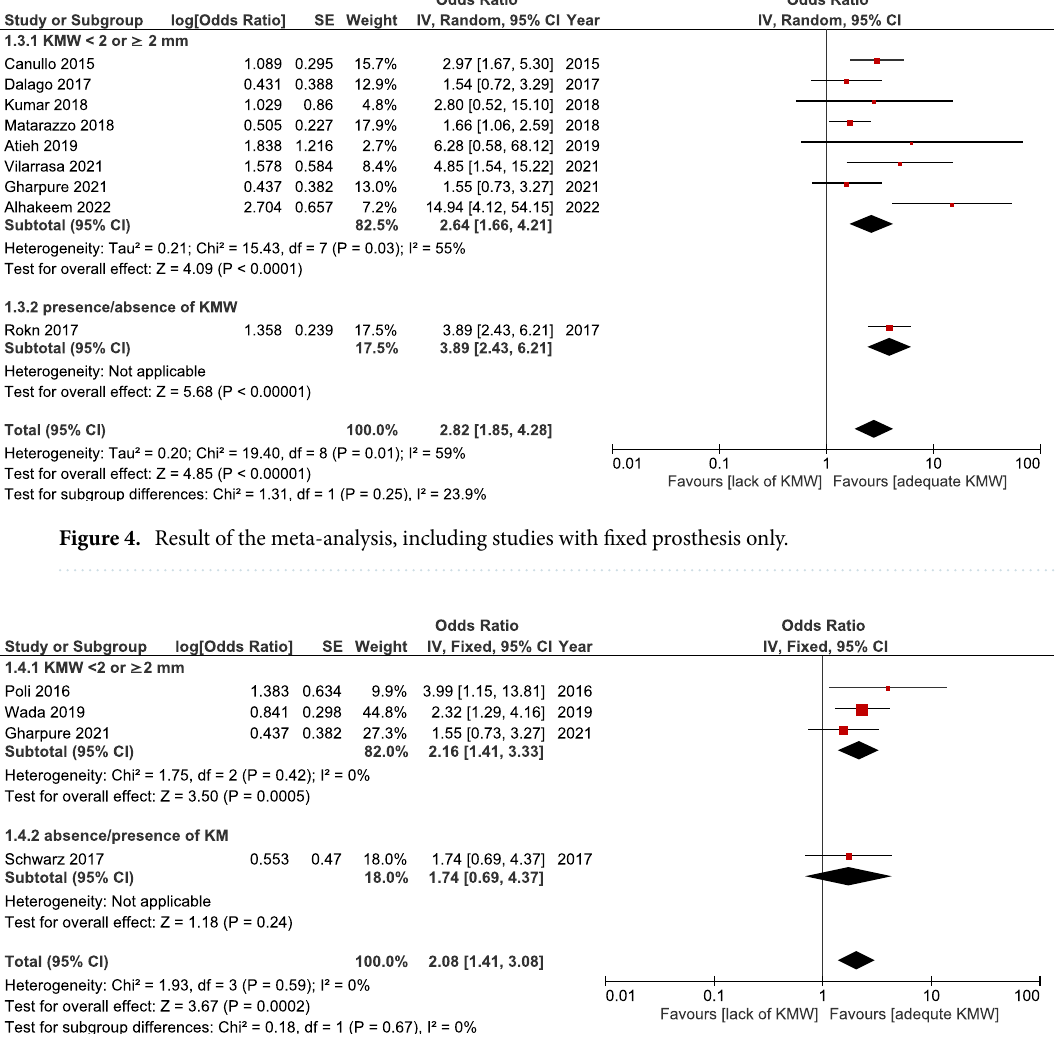
Figure 5. Result of the meta-analysis, including studies with patients under regular implant